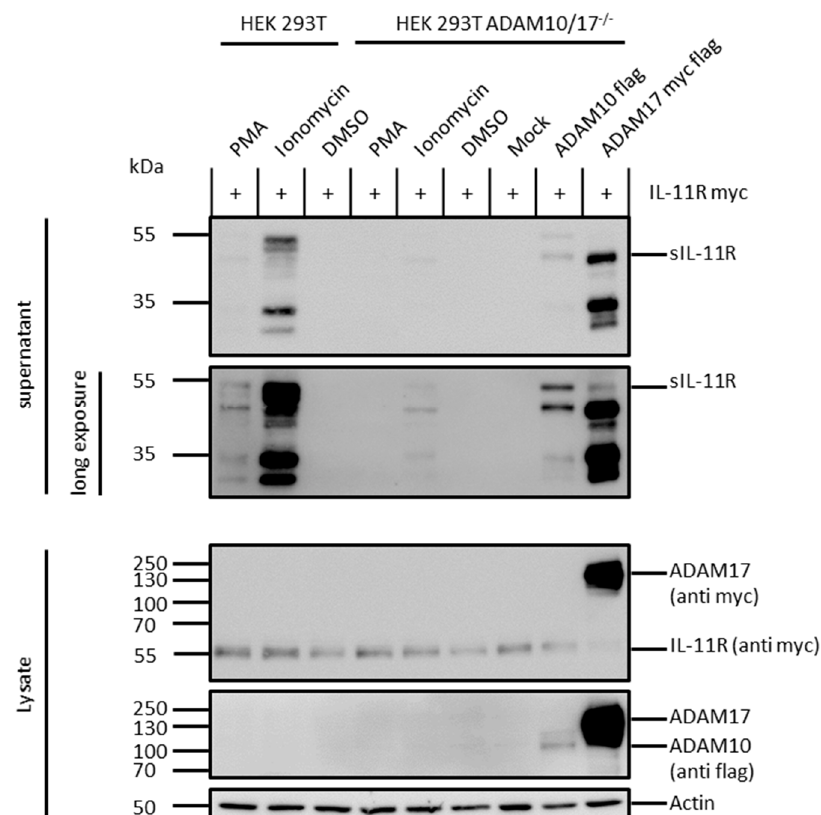
Figure 2. ADAM10 retransfected in HEK293T ADAM 10 / 17 − / − cells is capable of shedding the IL-11R. HEK293T wild-type cells (lanes 1–3) and HEK293T ADAM10/17 − / − cells (lanes 4–6) were transfected a N-terminally myc-tagged variant of the IL-11R and stimulated with phorbol myristate acetate (PMA) or ionomycin. Dimethyl sulfoxide (DMSO) served as control. HEK293T ADAM10 / 17 − / − were transfected with an N-terminally myc-tagged variant of the IL-11R and ADAM10 or ADAM17 (lanes 7–9). For both setups the supernatant was ultracentrifuged, TCA-precipitated, and analyzed by immunoblotting with di ff erent antibodies. ADAM10 flag-tagged, IL-11R myc-tagged, and ADAM17 flag- / myc-tagged were detected in lysate controls. pcDNA3.1 served as mock and actin as loading